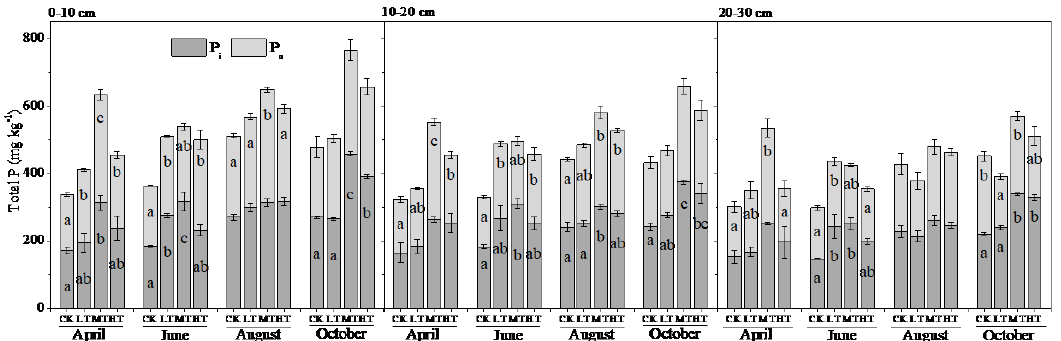
Figure 3. Response of total inorganic and organic P to thinning treatments at the three depths (0 − 10, 10 − 20 and 20 − 30 cm) at various sampling times in L. principis-rupprechtii plantations. CK, control site; LT, light thinning; MT, moderate thinning; HT, high thinning. Error bars indicate standard error ( n = 3). Values within each sampling time followed by different letters differ significantly according to Tukey’s test ( p < 0.05). When the difference was not statistically significant, no letter notation was noted.3.2. Soil P Fractions.